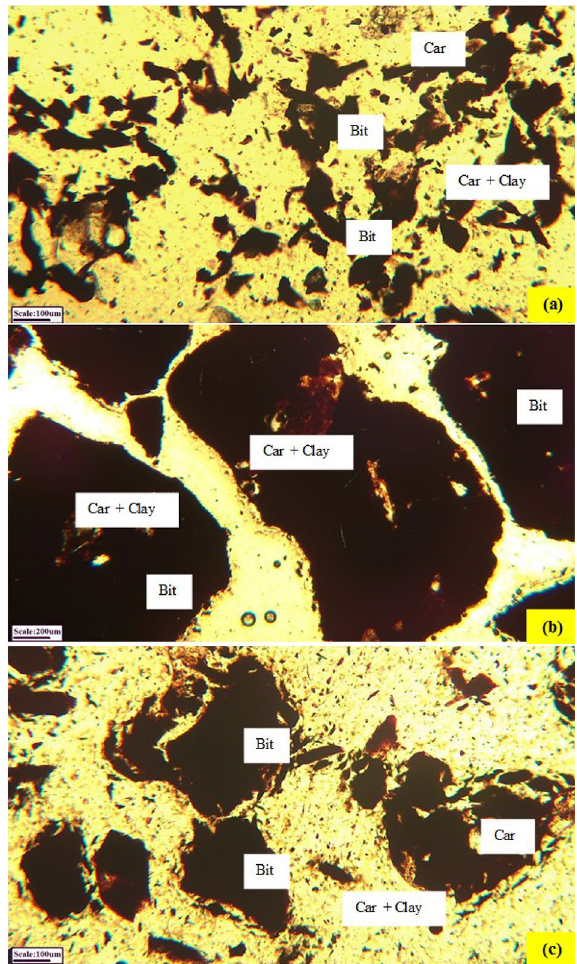
Figure 3. ( a ) Carbonate minerals (Car) in scattered and cracks filling forms and gangue distribution in − 105 µm fraction, ( b ) interlocking of minerals, and ( c ) gilsonite distribution in the 105–420 µm factions— [bitumen (Bit), carbonate (Car), clay (clay)]—microphotographs in plane polarized light